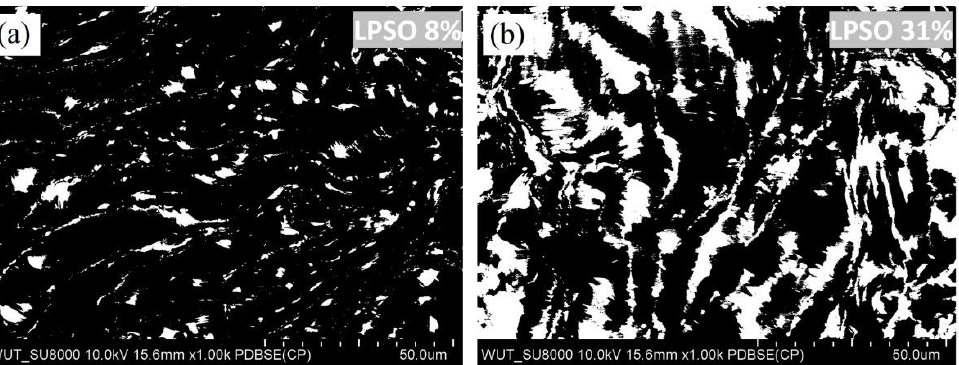
Figure 3. Representative binary images showing LPSO fraction in the investigated alloys: ( a ) WZ42, ( b ) WZ104; surfaces perpendicular to the extrusion direction.